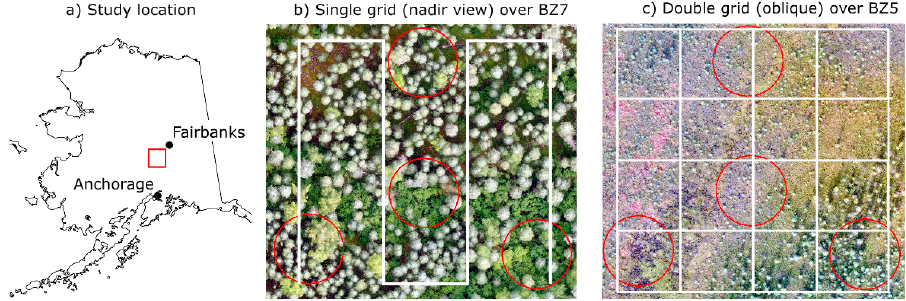
Figure 1. ( a ) Study location 30 km SW of Fairbanks AK in the Bonanza Creek Experimental Forest; ( b ) composite unmanned aerial vehicle (UAV) orthophoto from BZ7 with Forest Inventory and Analysis (FIA) subplots (red) and an example single-grid, nadir-view UAV flight plan (white); ( c ) composite UAV orthophoto from BZ5 with FIA subplots in red and white lines to illustrate an example double-grid, off-nadir flight